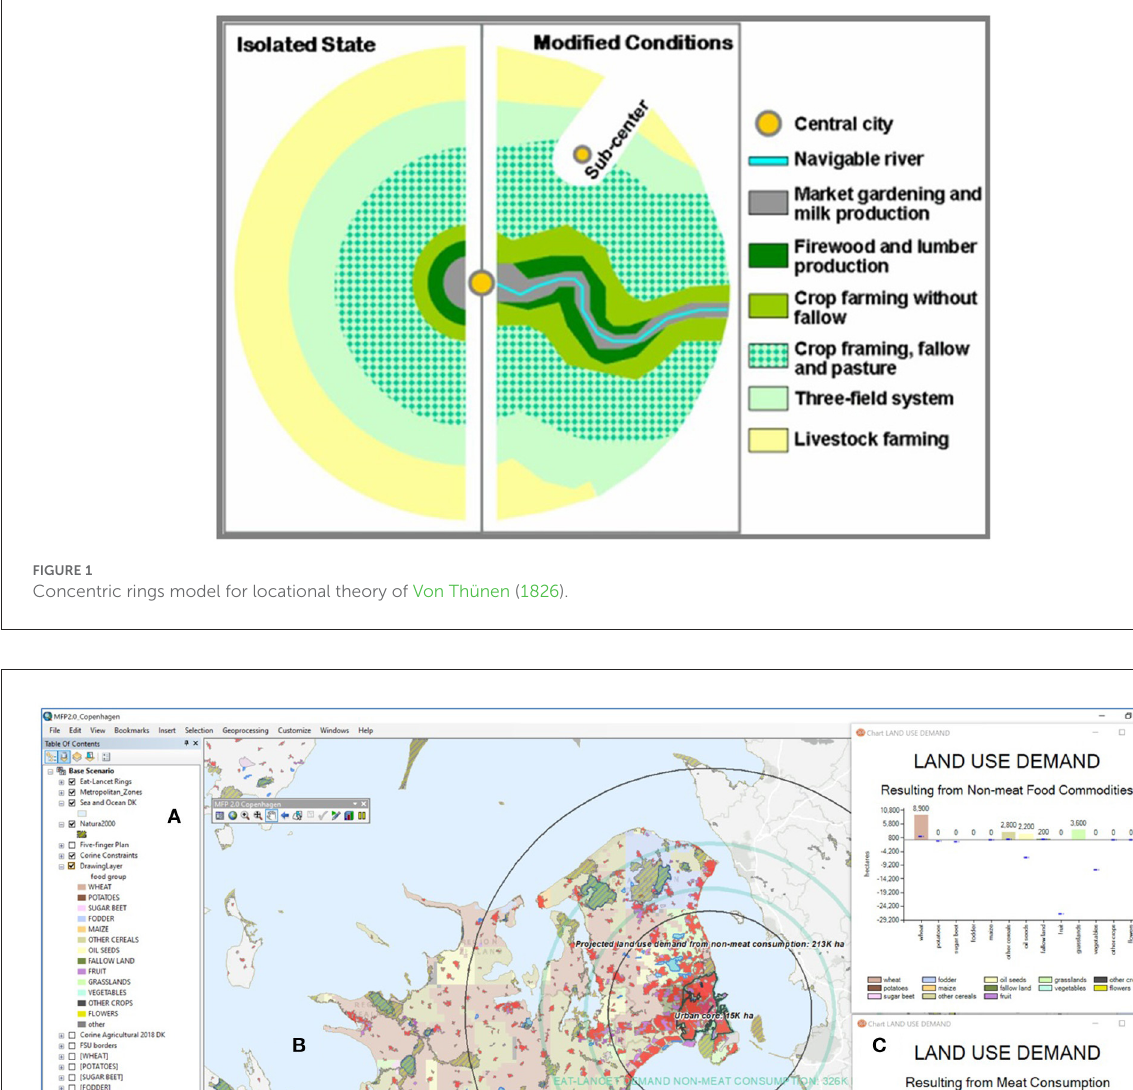
Map library and available